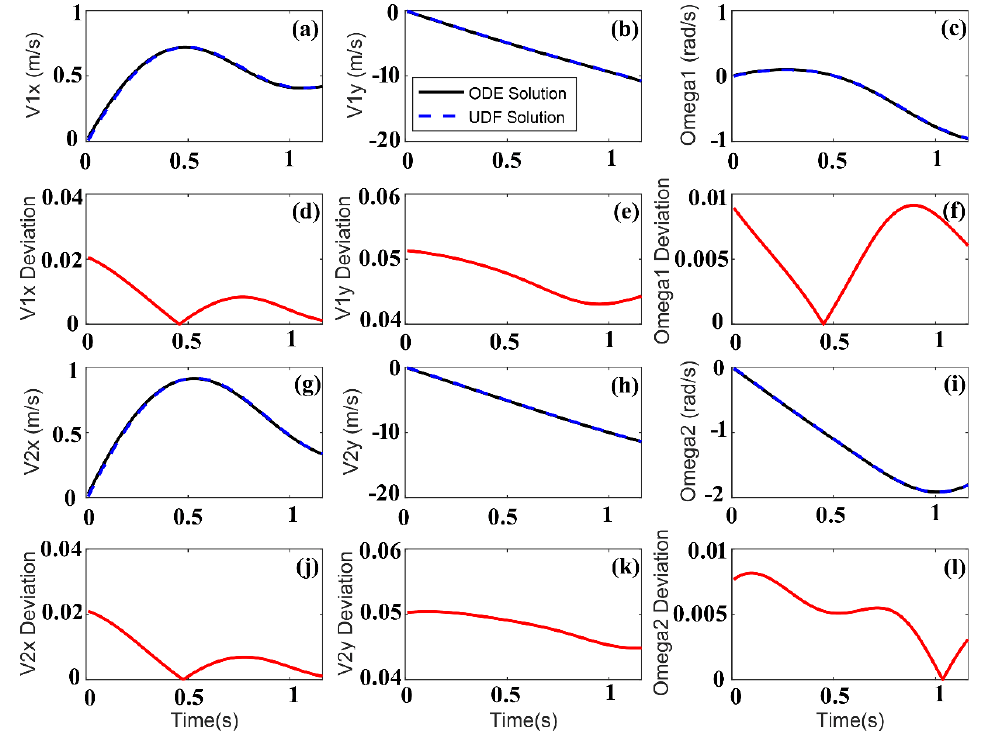
Figure 7. The comparison of UDF and Matlab ® ODE, including ( a ) velocity in X direction of body 1, ( b ) velocity in Y direction of body 1, ( c ) angular velocity of body 1, ( d ) velocity deviation between UDF and Matlab ® ODE in X direction of body 1, ( e ) velocity deviation between UDF and Matlab ® ODE in Y direction of body 1, ( f ) angular velocity deviation between UDF and Matlab ® ODE of body 2, ( g ) velocity in X direction of body 2, ( h ) velocity in Y direction of body 2, ( i ) angular velocity of body 2, ( j ) velocity deviation between UDF and Matlab ® ODE in X direction of body 2, ( k ) velocity deviation between UDF and Matlab ® ODE in Y direction of body 2, and ( l ) angular velocity deviation between UDF and Matlab ® ODE of body 2.